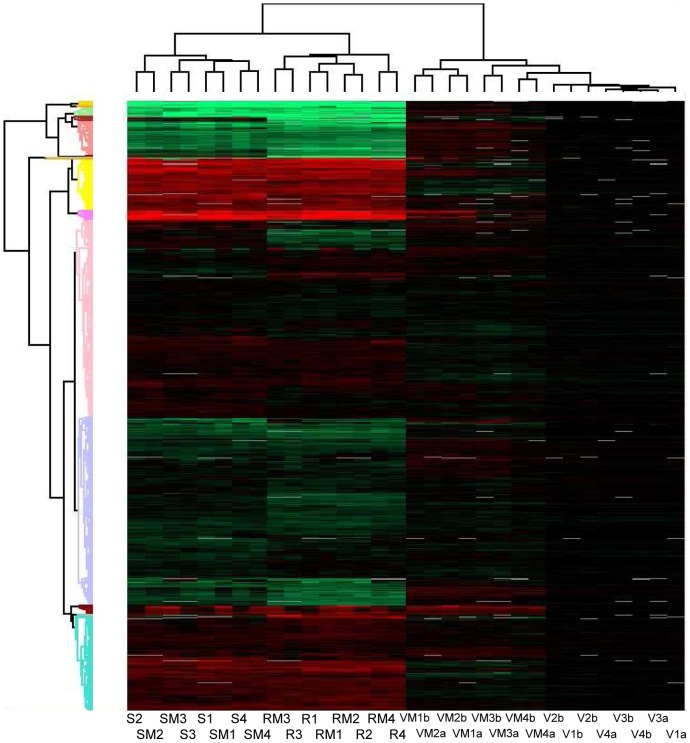
Hierarchical clustering analysis of protein expression using Perseus (Max Quant, v1.1.1.34). V(VLOO13). VM (VLOO13+Met). R (CD26A54_R). RM (CD26A54_R+Met). S (CD26A54_S). SM (CD26A54_S+Met). Green, reduced expression relative to VLOO13. Red, increased expression relative to VLOO13. Black, no difference in expression. White, no data. Number refers to experiment #. a, CD26A54_S set. b, CD26A54_R set.